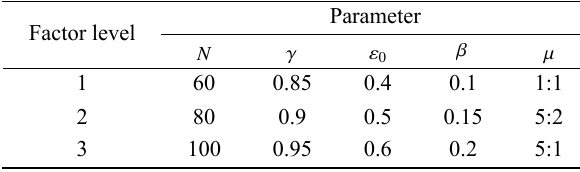
Table 4 Parameters and their levels.